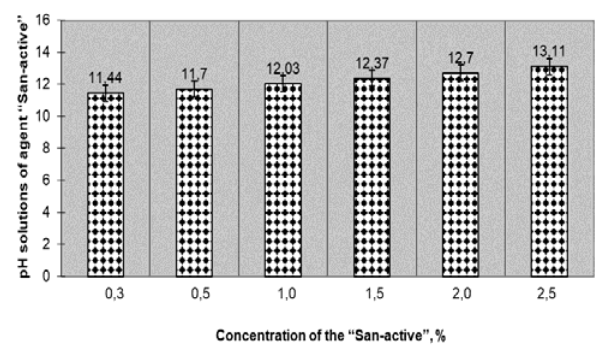
Fig. 1. рН solutions of agent “San-active” depending on its concentration